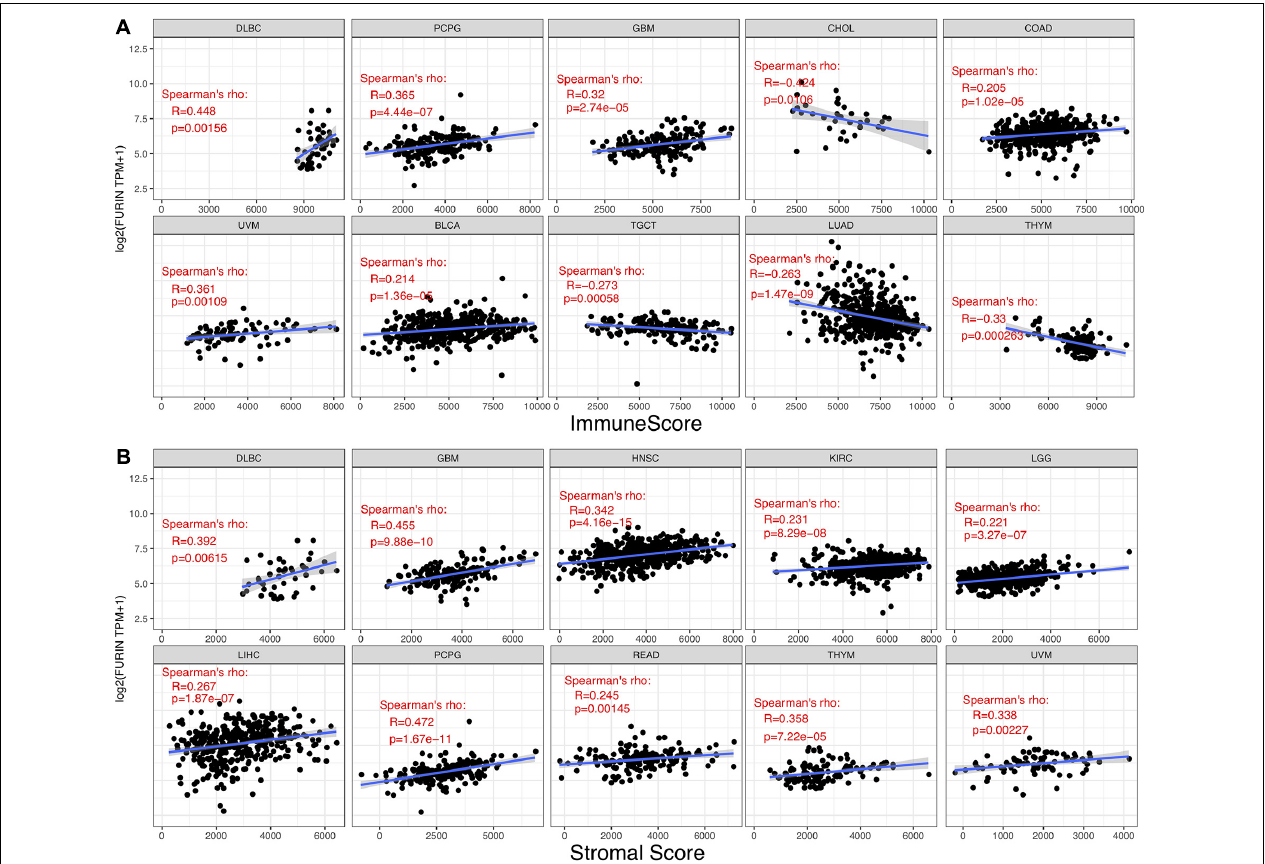
FIGURE 6 | Correlation of FURIN expression with ImmuneScore and StromalScore in various cancers. (A) Correlation of FURIN expression with ImmuneScore in DLBC, PCPG, GBM, UVM, BLCA, TGCT, LHAD, and THYM. (B) Correlation of FURIN expression with StromalScore in DLBC, GBM, HNSC, KIRC, LGG, LIHC, PCPG, READ, THYM, and